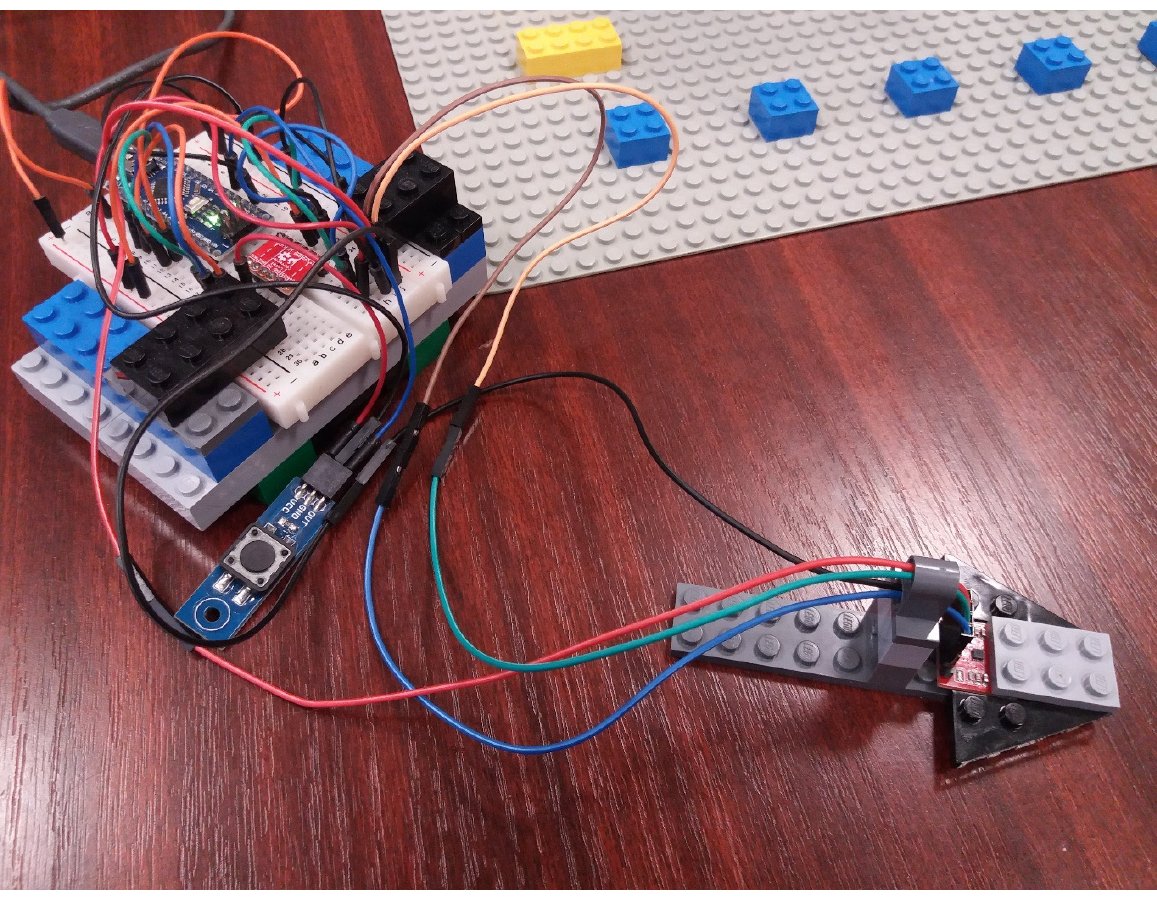
Figure 8. Experimental setup.